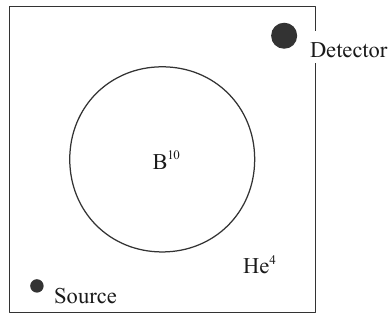
Fig. 1. Bypass simulation con